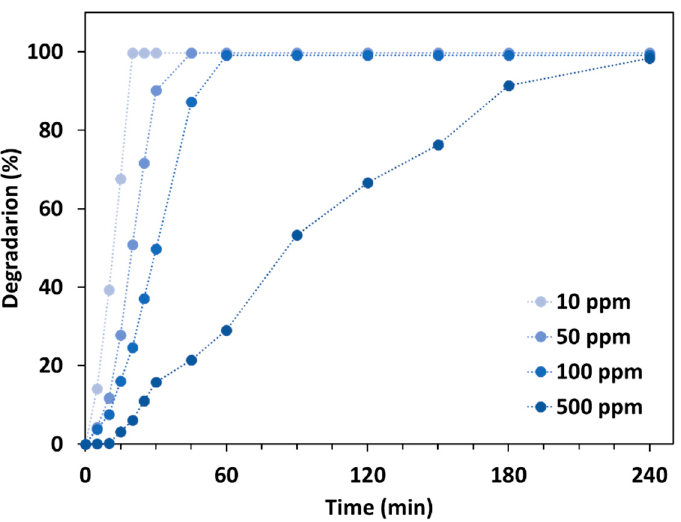
Figure 9. Degradation efficiency using different initial MB concentrations. Reaction conditions: [catechol-HCP-Fe] = 1 g/L, [H 2 O 2 ] = 0.5 M, pH = 6 (neutral pH), room temperature (27 °C).